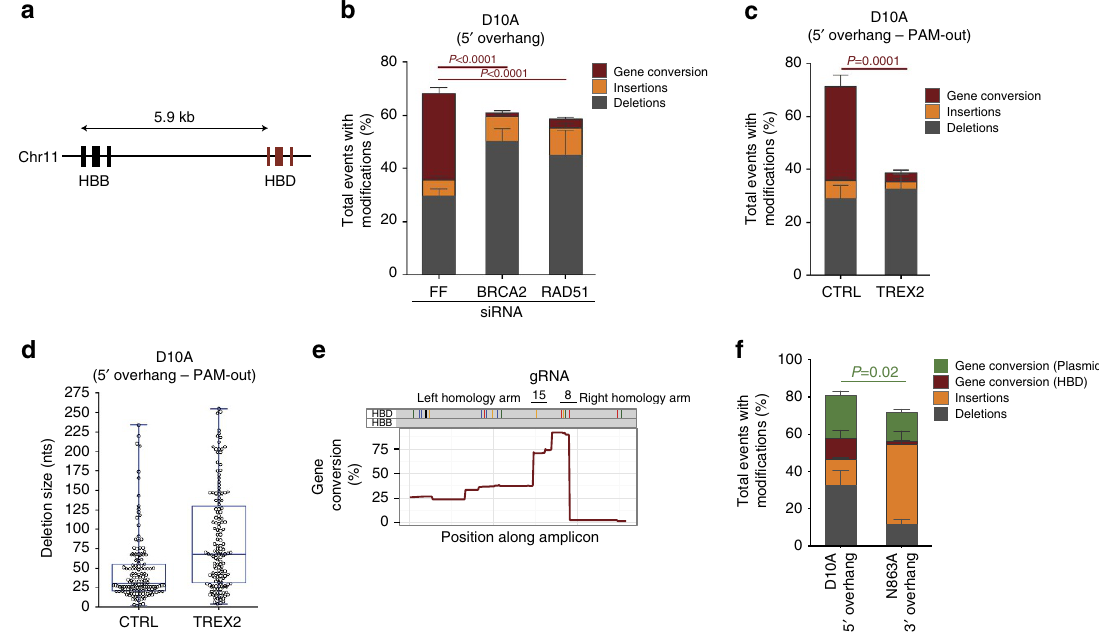
Figure 2 | Characterization of repair outcomes of lesions introduced with the D10A Cas9 variant using gRNA pair 8/15. ( a ) Schematic illustration of the HBB and HBD loci on chromosome 11. ( b ) U2OS treated with an siRNA against firefly luciferase (control, labelled as FF), BRCA2 or RAD51 in addition to the D10A Cas9 and gRNAs 8/15. The overall modification frequency at the HBB locus resolved for deletions, insertions and gene conversion (GC) was determined by Sanger sequencing. P values (GC) were calculated using the two-tailed Student’s t -test. Four independent experiments. Data are represented as mean ± s.e.m. Total number of sequences analysed: 476, 407, 389 for siFF, siBRCA2 and siRAD51-treated cells. ( c ) The overall modification frequency resolved for deletions, insertions and GC scored by Sanger sequencing of the amplified HBB locus in U2OS cells expressing the D10A Cas9 and gRNAs 8/15 in the presence (TREX2) or absence (CTRL) of TREX2. Due to limiting amplicon size primer pairs underestimate deletion frequency. P value (GC) was calculated using the two-tailed Student’s t -test. Five independent experiments. Total number of sequences: 578 for CTRL and 529 for TREX2. Data are represented as mean ± s.e.m. ( d ) Scatter dot plot overlaid with a box and whisker plot representing the deletions size from Sanger sequences of U2SOS cells expressing D10A Cas9 with gRNAs 8/15 in the presence (TREX2) or absence (CTRL) of TREX2. Each individual dot represents one Sanger sequence with a deletion. Due to limiting amplicon size primer pairs underestimate deletion frequency. The line within the box depicts the median, with the box extending from the 25th to the 75th percentiles. The whiskers depict the minimum and maximum values of the data set. Five independent experiments, total number of sequences: 147 for CTRL and 149 for TREX2. ( e ) Graph showing positions of nucleotide mismatches (colours) and deletions (black) between the HBD and the HBB genes as coloured rods (top). Histogram of relative GC frequency plotted as a function of the position on the HBB locus (bottom). ( f ) Overall modification frequency at the HBB locus separated into deletions, insertions and GC from either the endogenous HBD gene or a plasmid source. The different repair outcomes after D10A or N863A Cas9 activity in U2OS cells followed by Sanger sequencing of individual HBB amplification products. Four independent experiments. Data are represented as mean ± s.e.m. P value (Gene conversion (plasmid)) was calculated using the two-tailed Student’s t -test. Total number of sequences analysed: 199 and 304 for D10A Cas9 and N863A